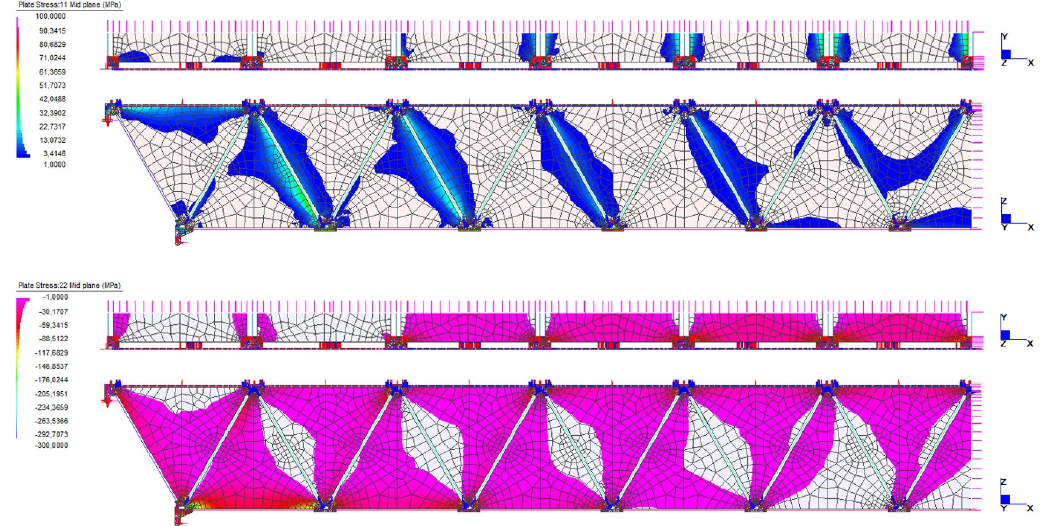
Figure 13. BM TVT γ‐ bis ULS non ‐ linear static analysis: at the top, maximum principal stress; at the Figure 13. BM TVT γ -bis ULS non-linear static analysis: at the top, maximum principal stress; at the bottom, minimum principal stress. bottom, minimum principal